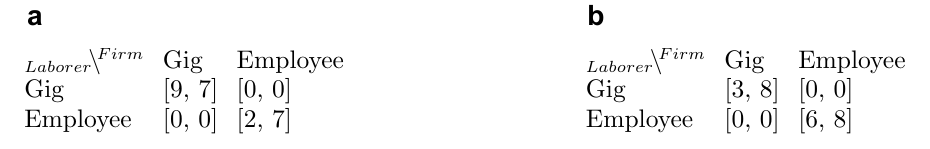
Figure A7. Payoffs for vertical attractor arc demonstration. ( a ) Bear market, n = 0; ( b ) Bull market, n = 1.